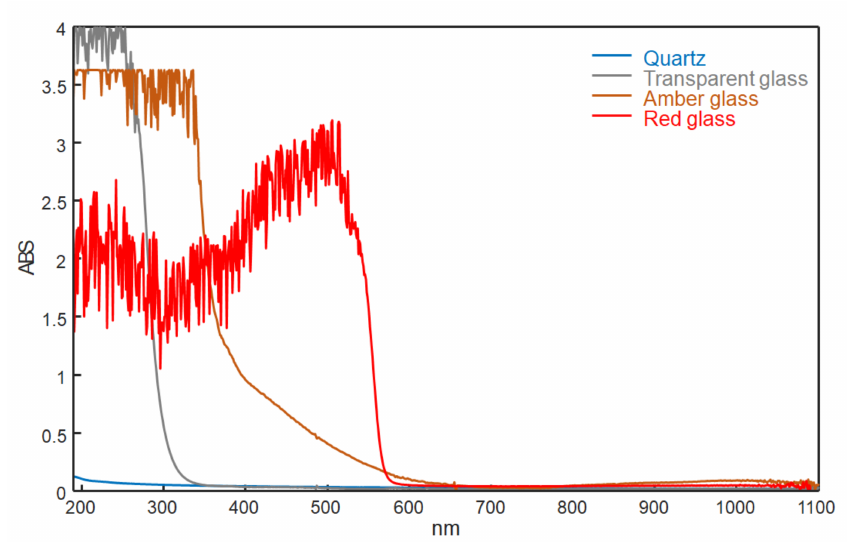
Figure 5. Absorbance spectra of quartz, transparent, amber, and red